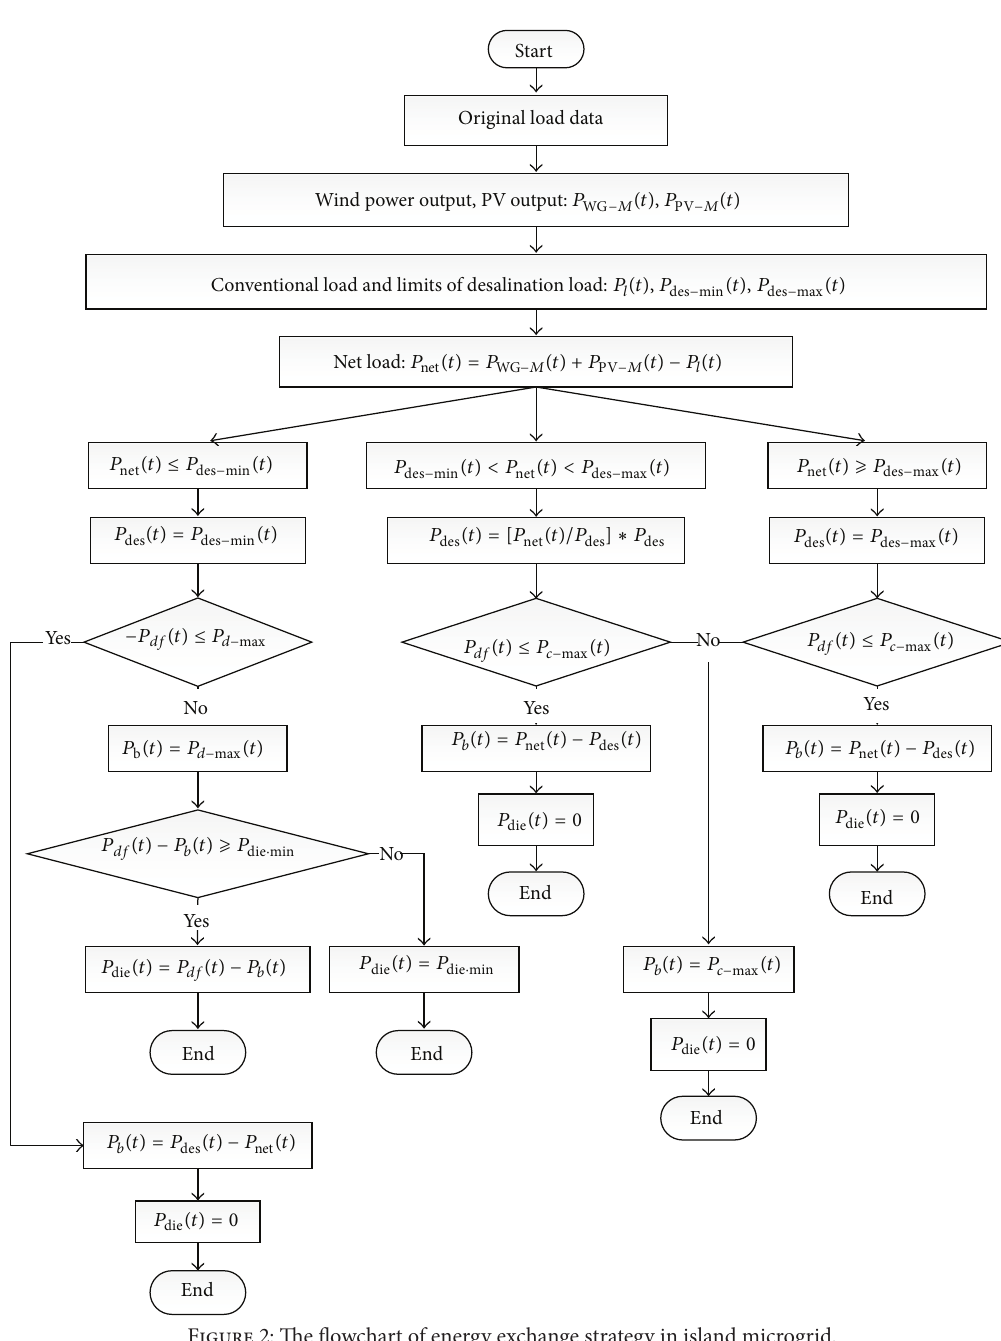
Figure 2: The flowchart of energy exchange strategy in island